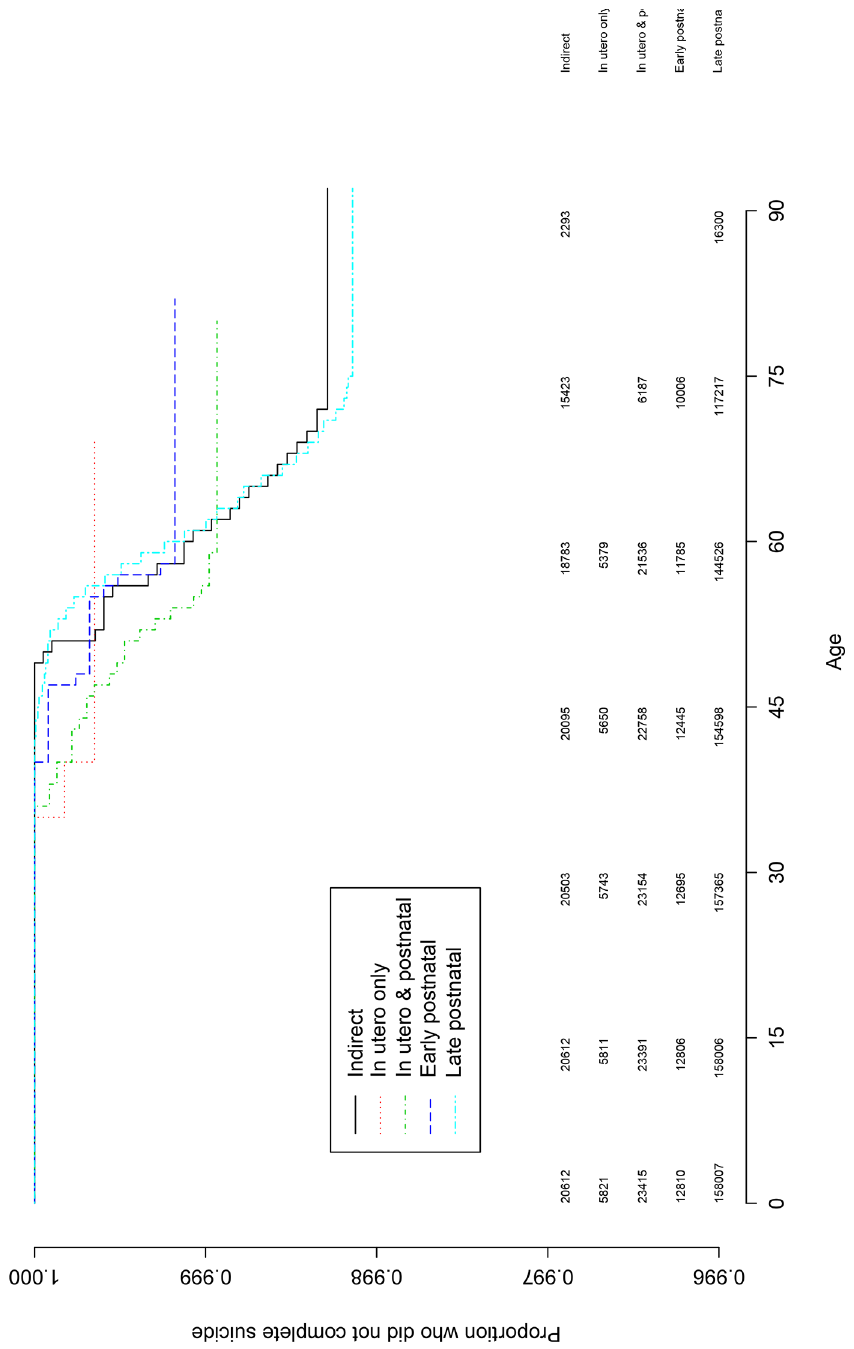
Fig 2. Kaplan-Meier survival curve for the cumulative probability of suicide risk for the indirect, in utero only, in utero and postnatal and late postnatal exposure subgroups. Note. The curves depict average age of suicide for the exposure groups based on Kaplan-Meier modeling estimates. The vertical axis is the proportion that did not complete suicide. The numbers under the horizontal axis are age, and the numbers above the x-axis are the numbers at risk every 15